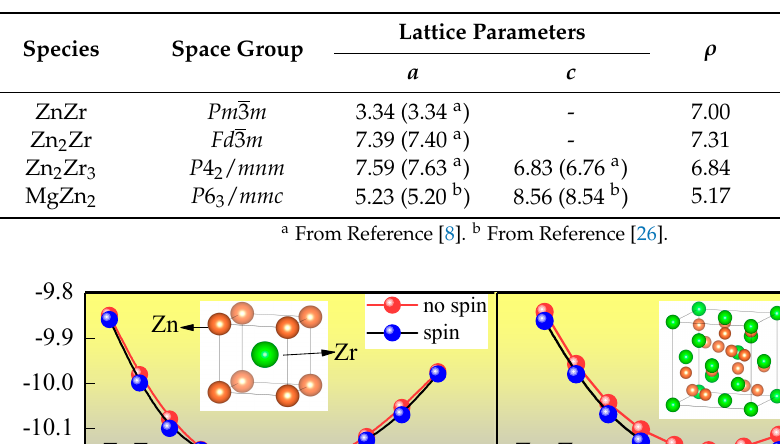
Table 1. The calculated lattice parameters at the ground state ( a , c in Å, ρ in g/cm 3 ) and the fitting bulk modulus B 0 (GPa) at the spin state, as well as the Helmholtz free energy F (eV/atom) at 0 K. For MgZn 2 , the B 0 responds to the no-spin state.